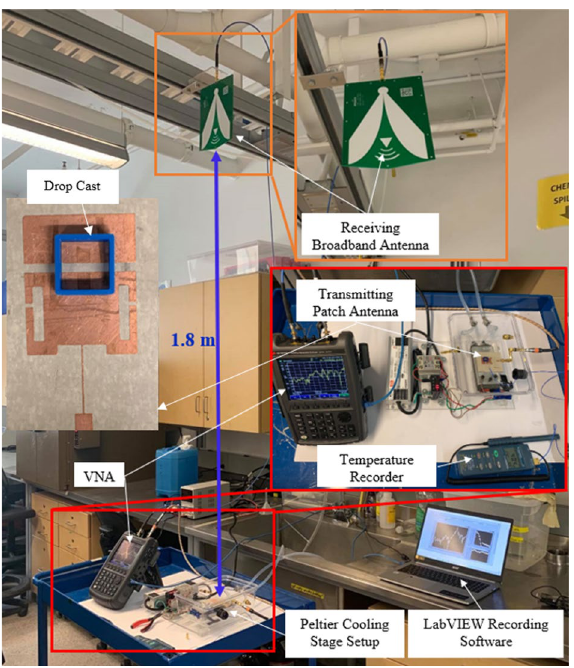
Figure 7. The experimental setup and fabricated patch antenna. The setup utilized a Peltier cooling stage to freeze ice onto the sensing antenna which then transmitted to a receiving antenna positioned 1.8 m above the